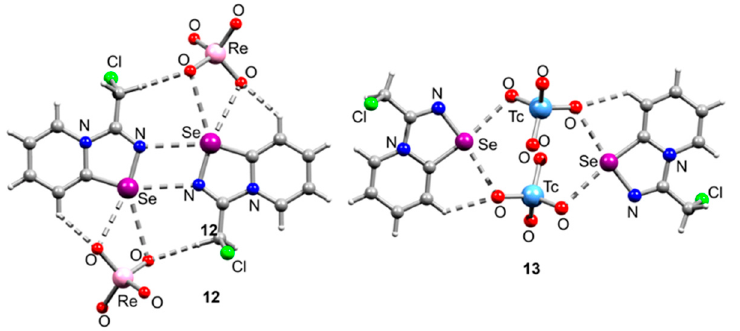
Figure 9. Ball-and-stick representation of the crystal structure of 12 and 13 , demonstrating supramolecular dimerization via ChB interactions.